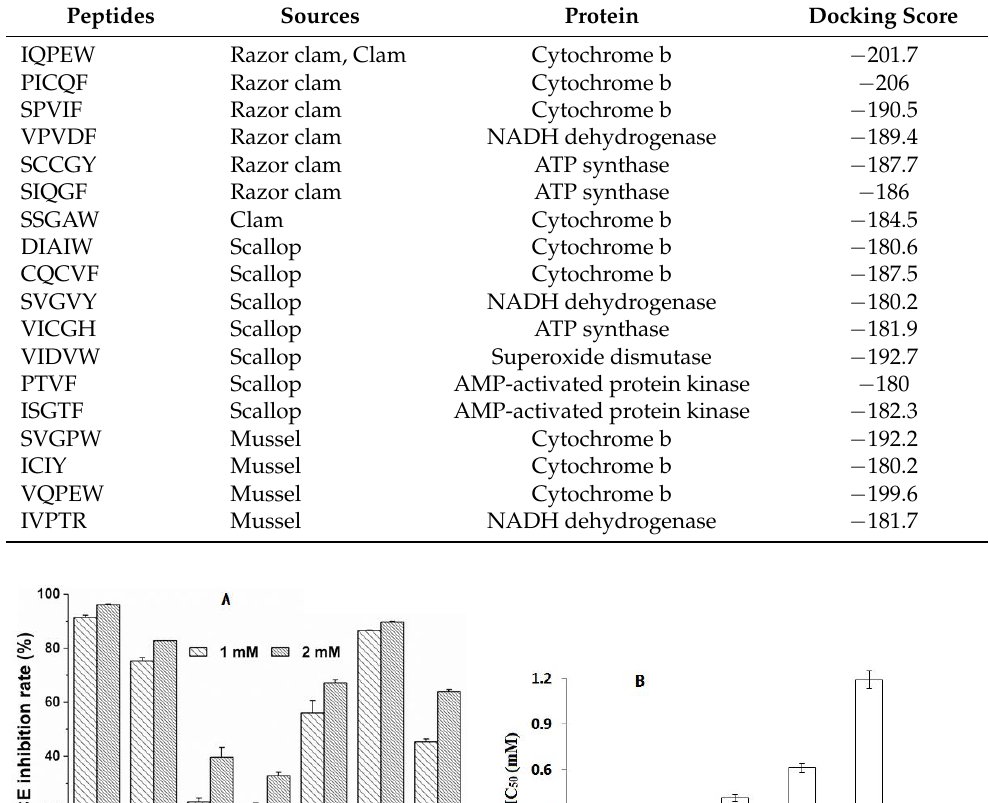
Table 2. Top high-affinity oligopeptides.